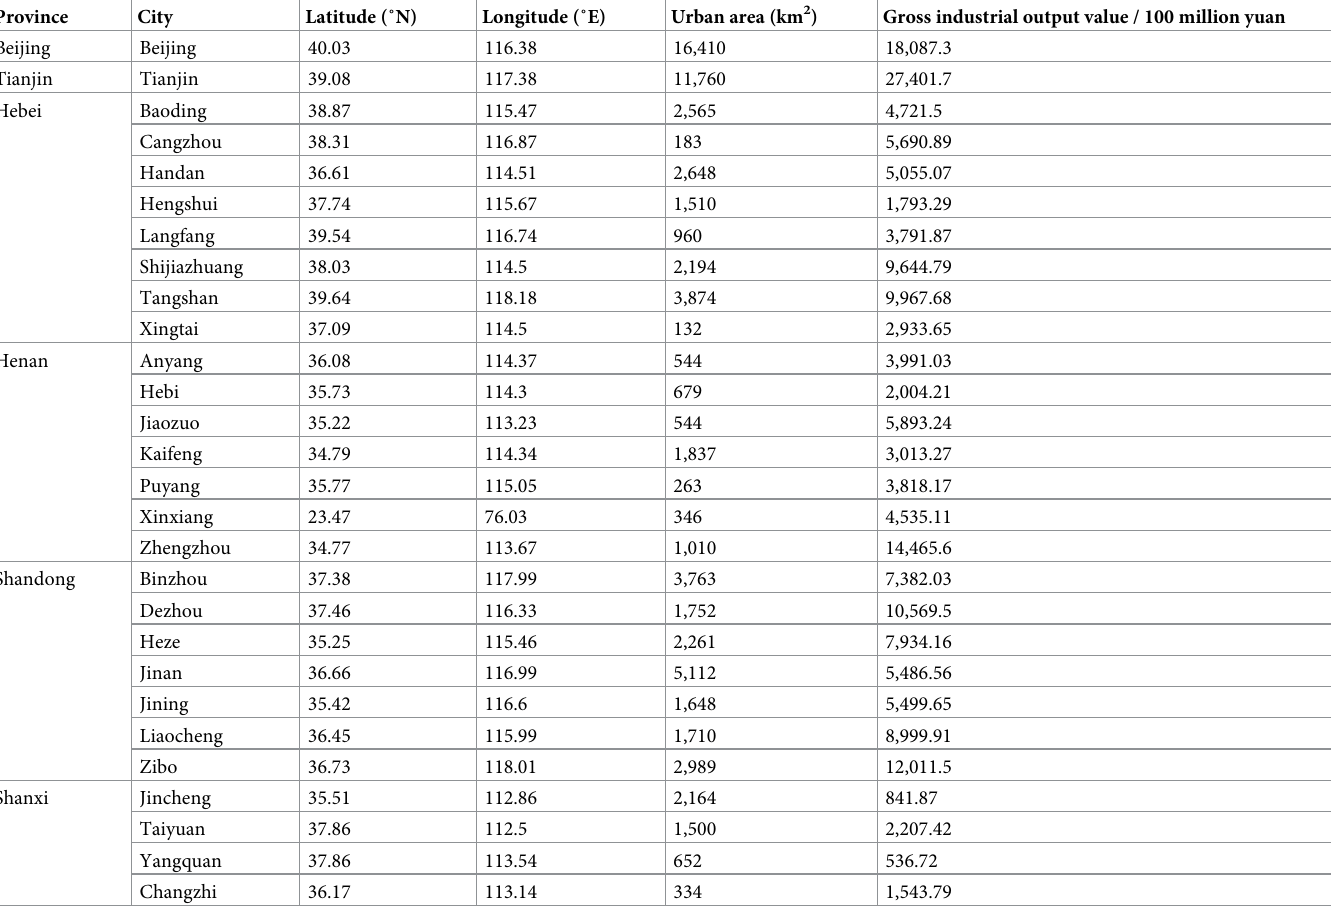
Table 1. Basic information on the “2+26” cities of Beijing-Tianjin-Hebei and its surrounding